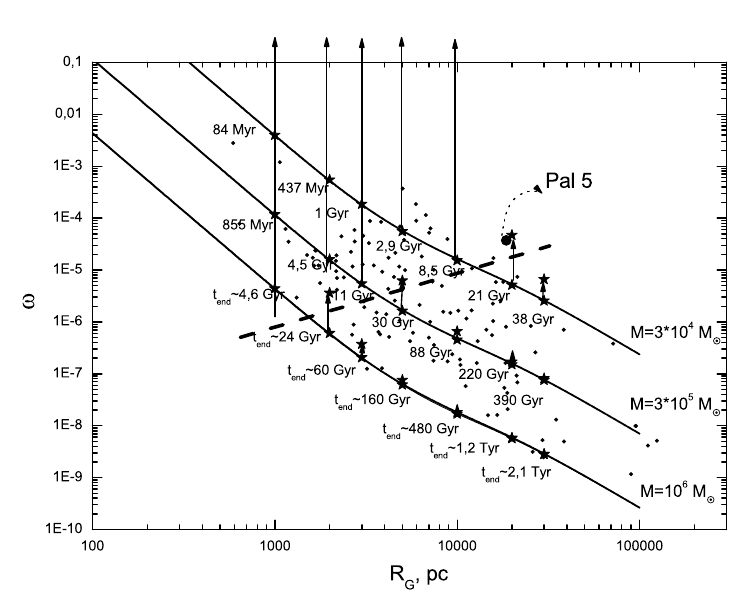
Fig. 6. The dependence of the parameter of GC resistance to tidal dissolution on the galactocentric distance. down a quite exact low-dimensional system of ordinary di(cid:27)erential equations to describe GC evolution, therefore equation (2) may be used for crude estimates